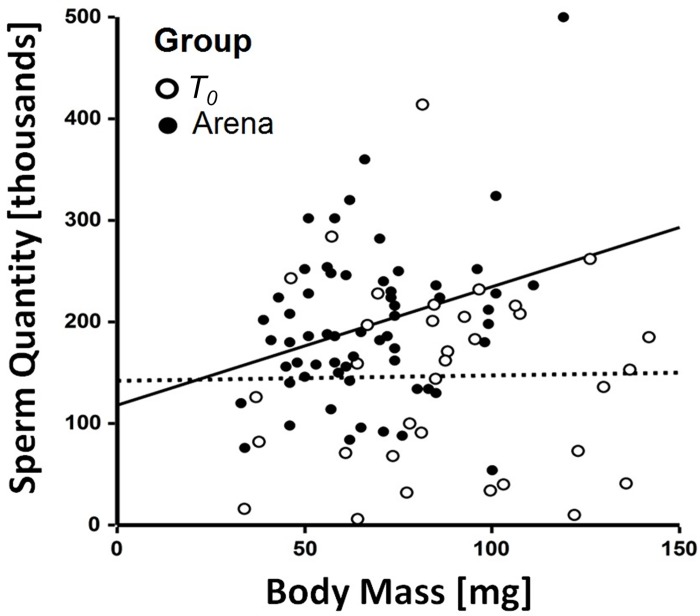
Correlation of body mass and sperm quantity in male Osmia
cornuta: Immediately post emergence
(T0) (white circles, no significant
correlation between body mass and sperm quantity) and four days after
emergence (black circles, solid line illustrating a significantly
positive correlation between body mass and sperm quantity (Spearman’s r
= 0.30).